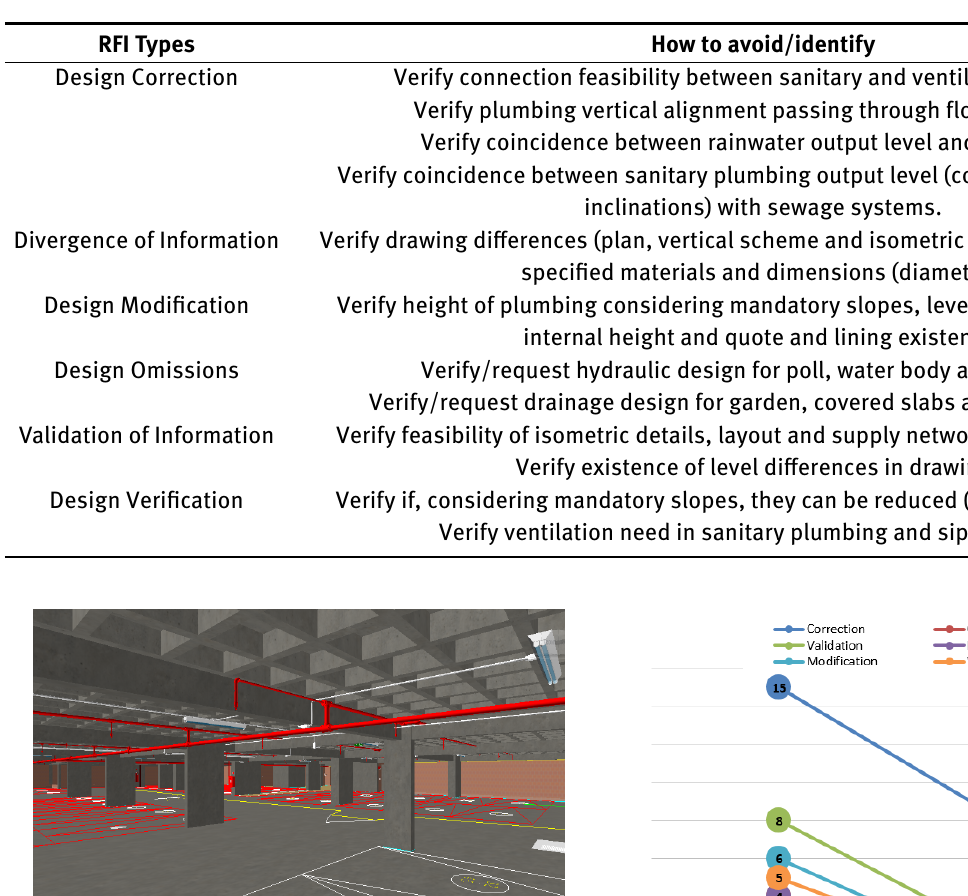
Table 2: How to identify and avoid MEPF Systems problems.